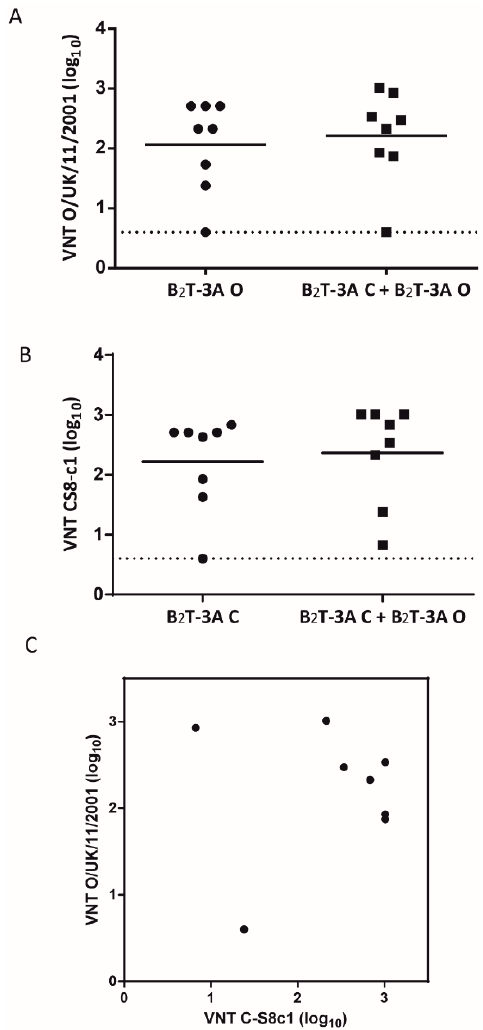
Figure 2. The mixture of two heterotypic B 2 T-3A constructs elicited similar levels of neutralizing antibodies against Type C and Type O FMDVs. Neutralizing antibody titers in sera samples on day 40 pi from mice immunized twice (on days 0 and 21) with an equimolar mixture of B 2 T-3A-O + B 2 T-3A-C or with B 2 T-3A-C or B 2 T-3A-O against Type O FMDV (O/UK/11/2001 isolate) ( A ) and Type C FMDV (C-S8 isolate) ( B ). ( C ) To measure the relationship between antibody titers to serotypes C and O in each animal, Pearson’s correlation coefficient (r) was calculated: r = 0.07. Each point represents the mean of a triplicate assay of each animal (n = 8). Values are expressed as the reciprocal log 10 of the serum dilution that neutralized 100 TCID 50 of each FMDV.